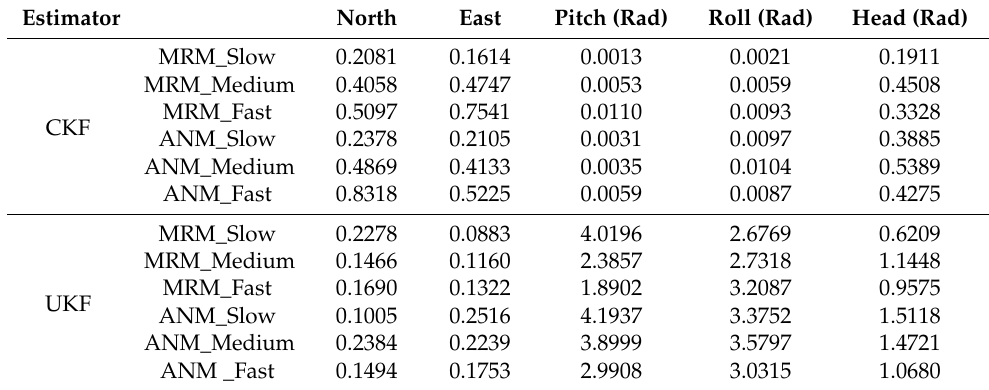
Table 1. RMSE coefficients of different models and different estimators. Estimator North